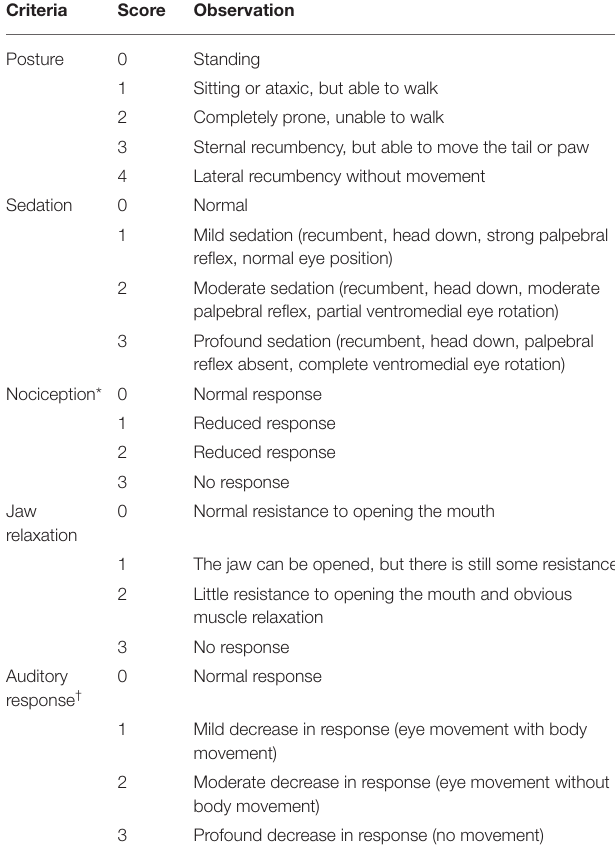
TABLE 1 | Behavioral